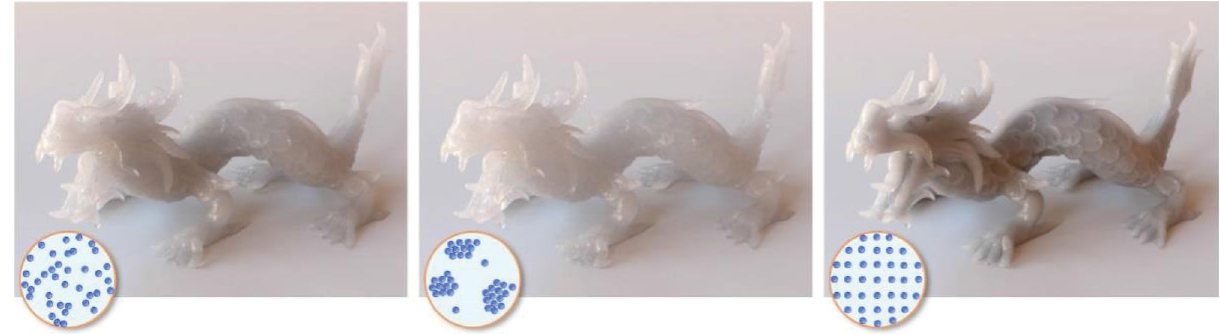
Fig. 22 Results for randomly distributed, mutually attracted, and mutually repelling particles. Reproduced with permission from Ref. [71], c (cid:2) ACM